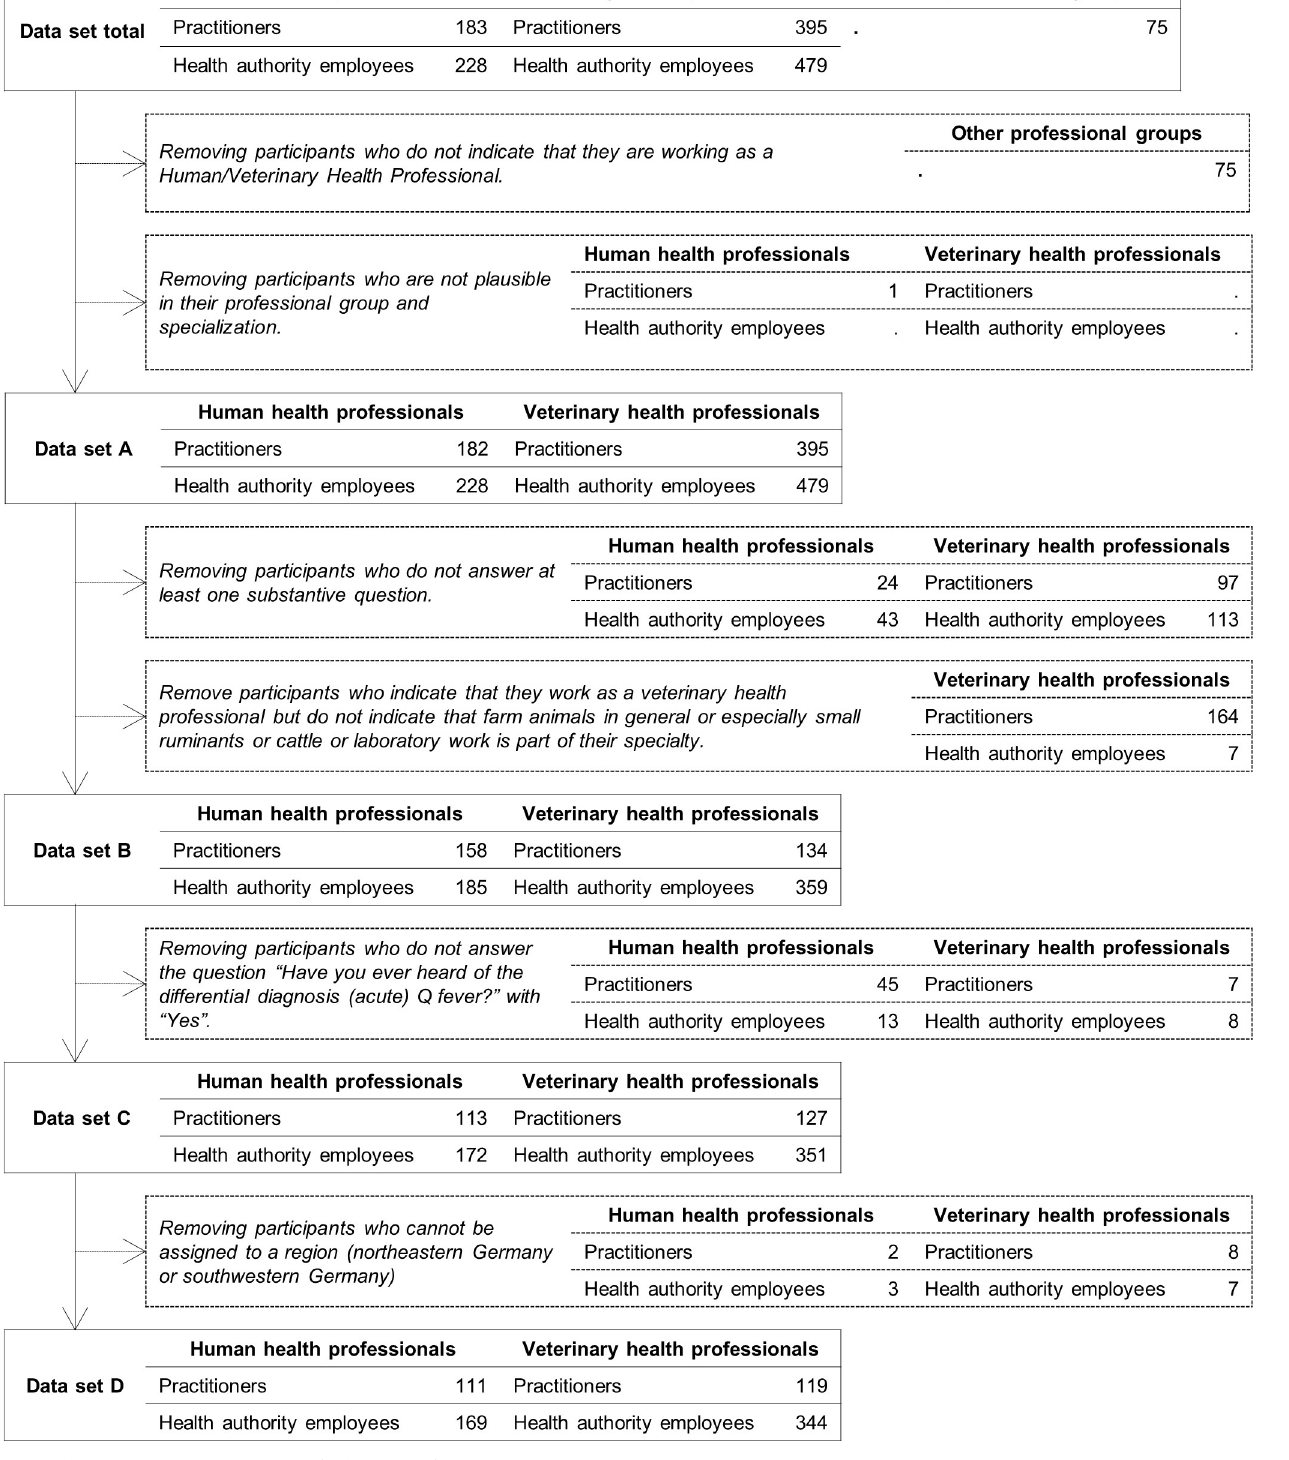
Fig 2. Plausibility check and data sets (online survey).